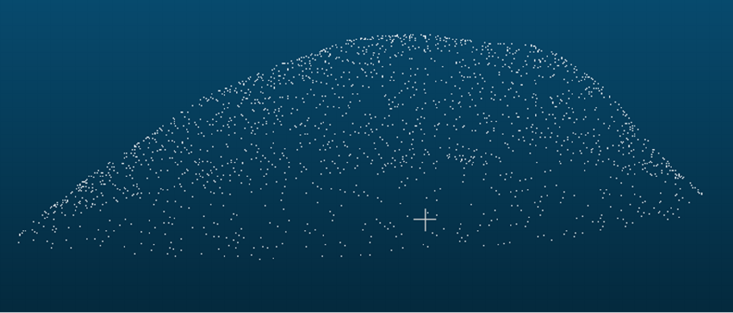
Figure 3. The point cloud data after processing.